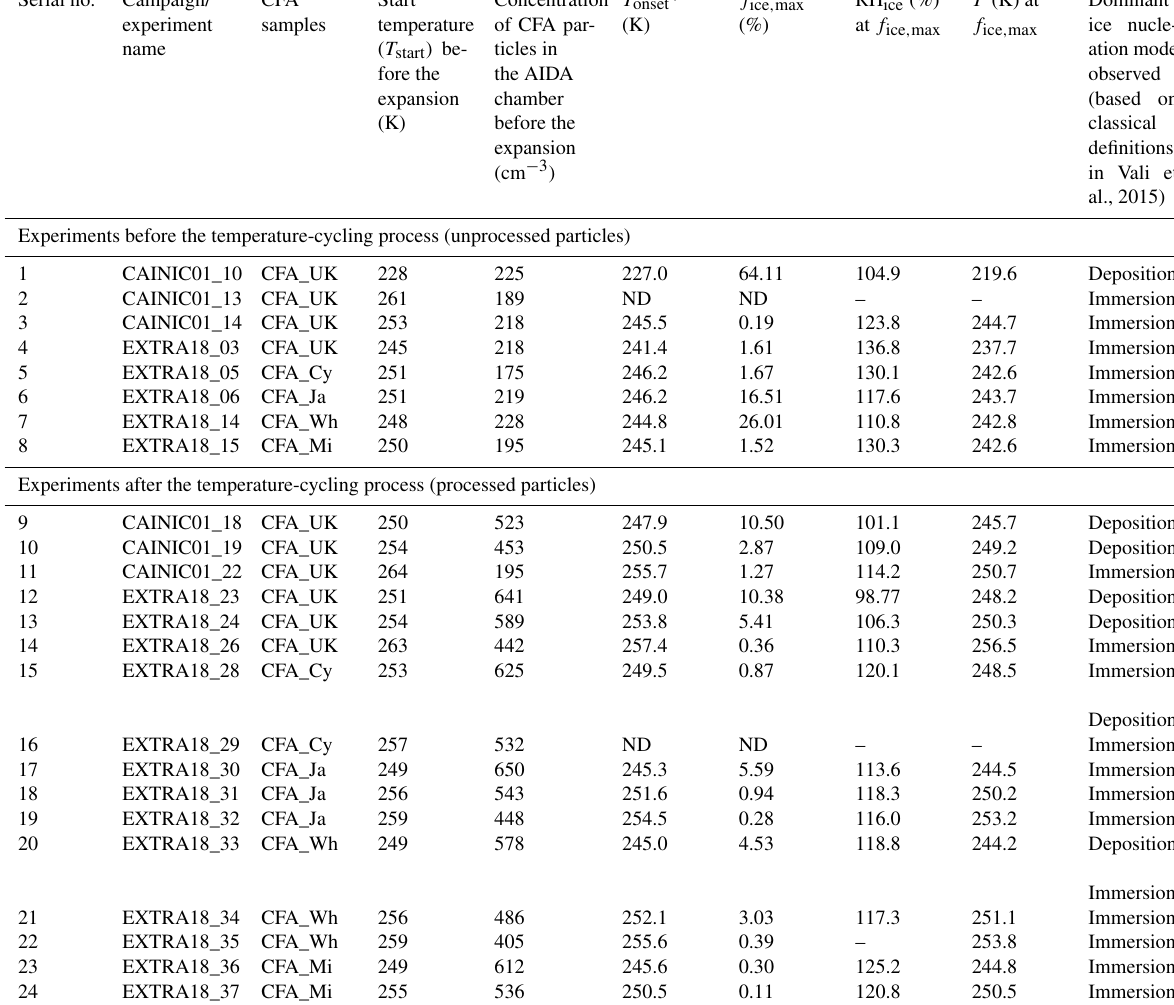
Table 2. Information on the various ice nucleation experiments conducted during two distinct AIDA measurement campaigns: CAINIC01 and EXTRA18. Experiments (1–8) were conducted with unprocessed CFA particles, whereas experiments (9–24) were performed with processed CFA particles (i.e. after the temperature-cycling process involving intermediate cooling to ∼ 228K, see Sect. 2.6). The freezing modes mentioned here are based on the classification presented in Vali et al. (2015). Serial